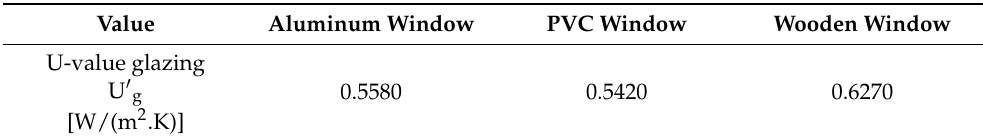
Table 4. Data calculated according to the standard.